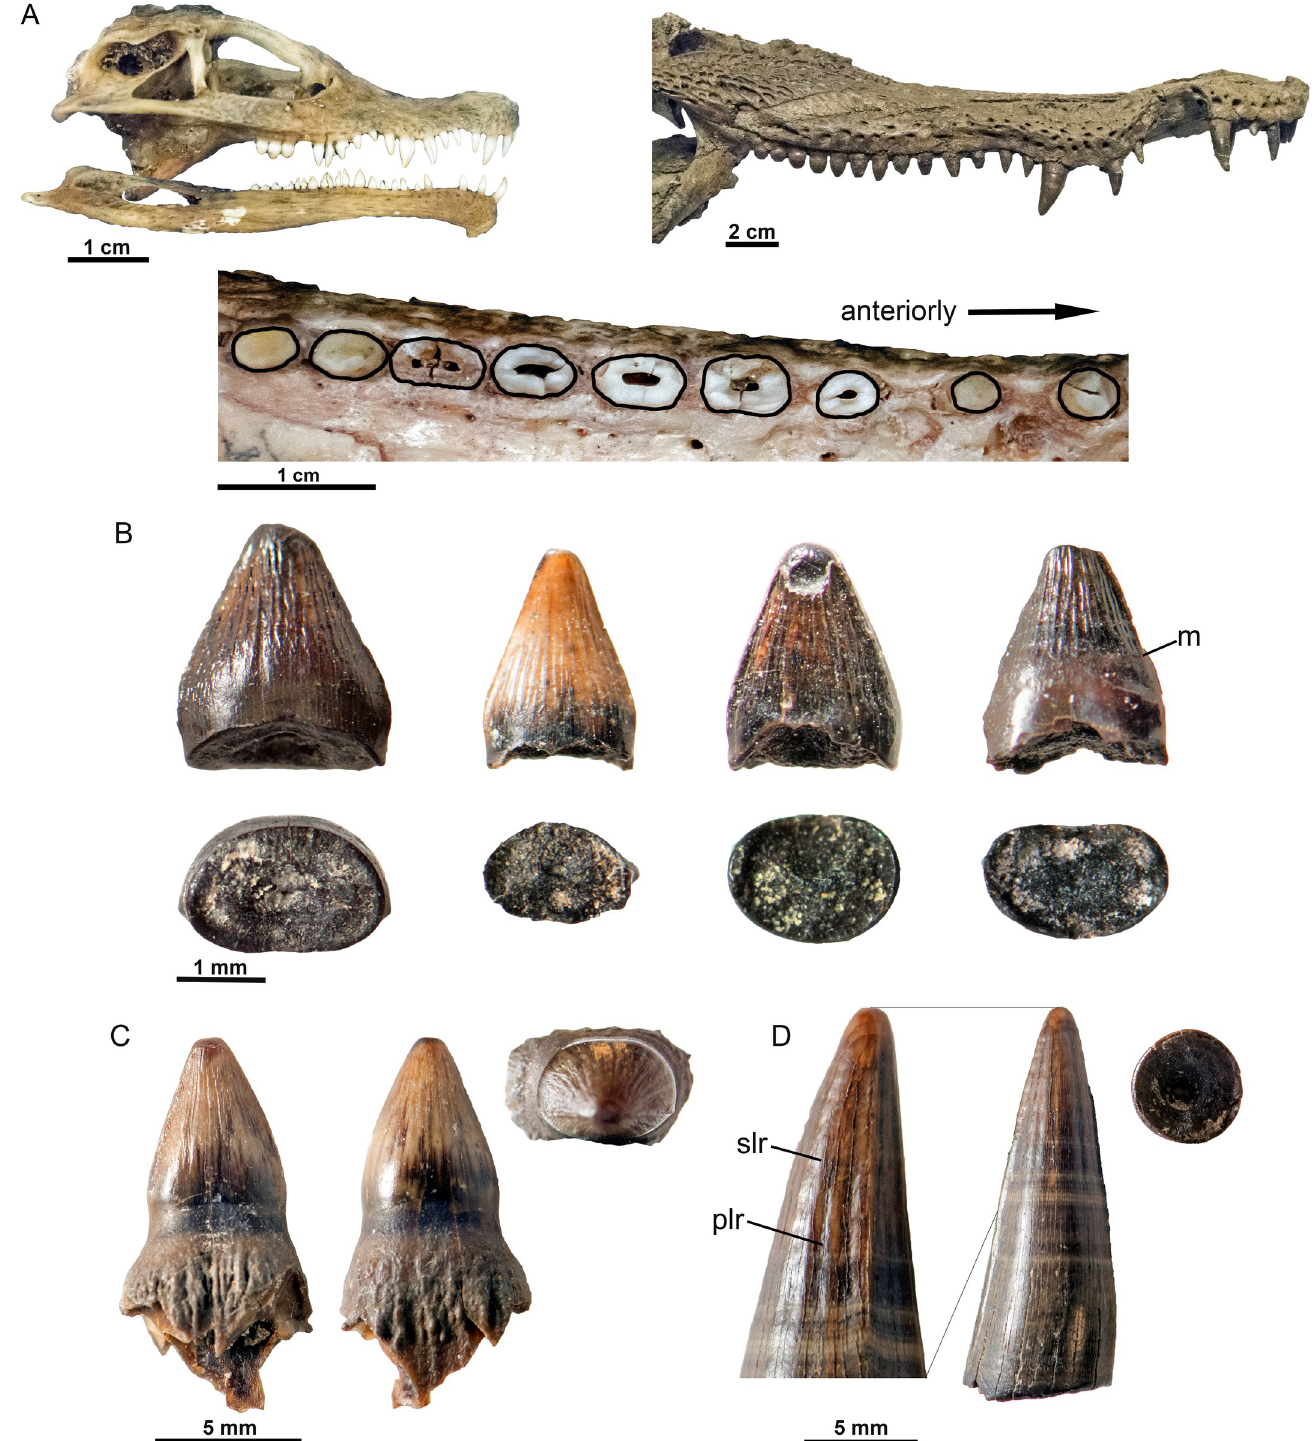
Fig 4. Variation of tooth shape in crocodilian jaws and small fossil crocodilian teeth from the Dinosaur Park Formation, Alberta. A , juvenile Alligator skull; B , skull of UALVP 40954 in lateral view; C , dorsal aspect of Caiman maxilla with tooth shape in apical view outlined in black; D , selection of teeth from TMP 1986.8.74 (presumably crocodilian) in lateral and basal views. Note the ridges present on all four crowns, and possible enamel margin; E , UALVP 54359A in lingual, labial, and apical views, F , UALVP 54359B in lateral and basal views, including details of ridges near the apex of the crown. Abbreviations: m, margin, plr, primary longitudinal ridges, slr, secondary longitudinal ridges. Crocodilian fossils, especially isolated teeth and scutes, are relatively common in Late Cretaceous